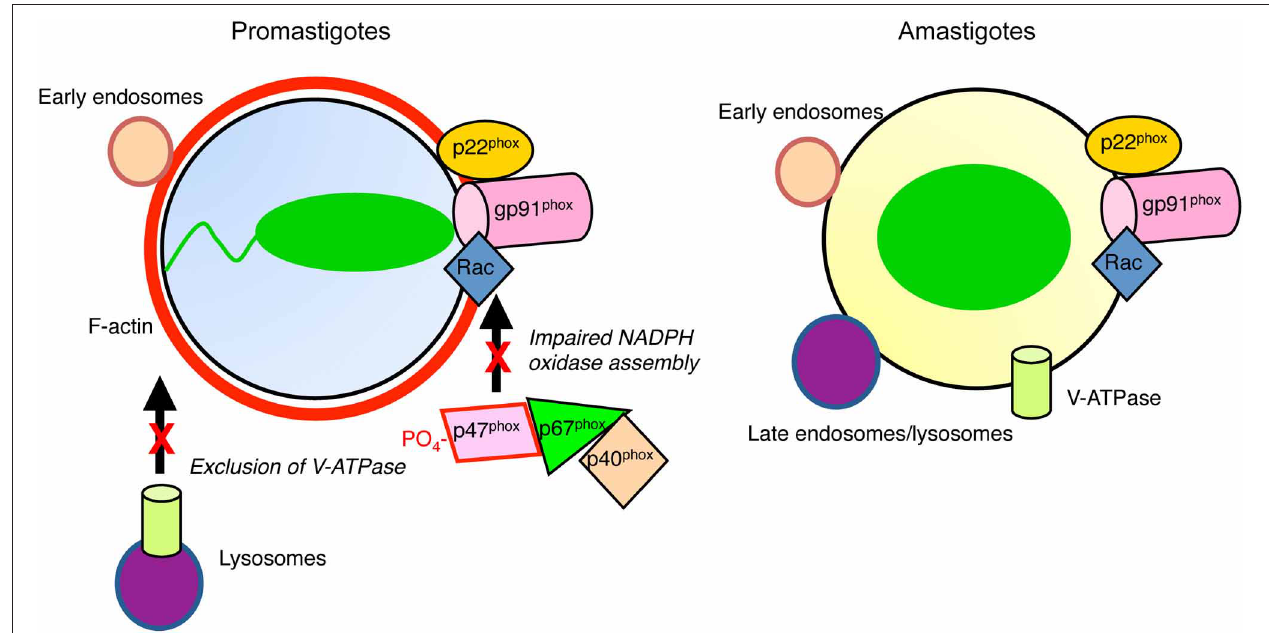
FIGURE 1 | Diagram illustrating inhibition of phagosome maturation induced by L. donovani promastigotes. Periphagosomal F-actin (red) accumulates, whereas promastigote-harboring phagosomes interact with early endosomes (tan). In contrast to amastigote-containing phagosomes,